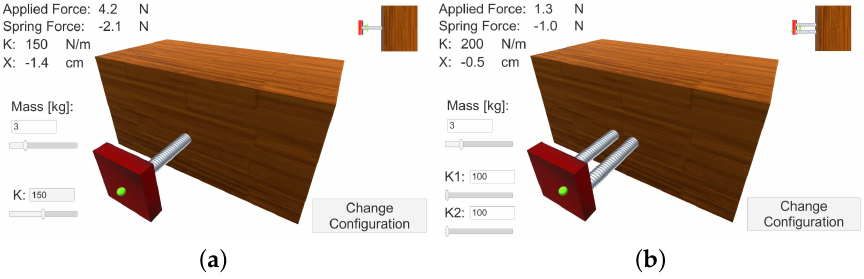
Figure 13. Hooke’s Law scenarios: ( a ) simple spring and ( b ) double springs.